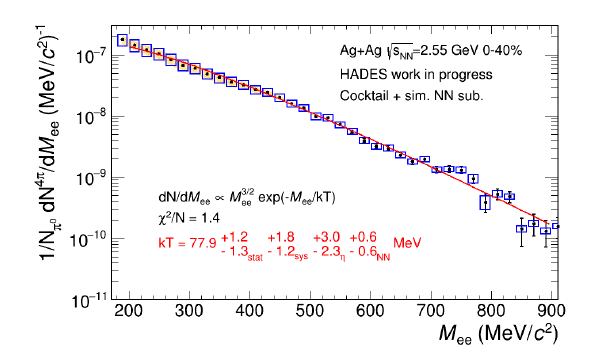
Figure 5. Subtraction of the hadronic cocktail and the initial NN contribution reveals the in-medium dielectron signal. The exponential shape is fitted with a thermal distribution resulting in an integrated medium temperature of T ∼ 78 MeV . The uncertainty in the η multiplicity is indicated by the yellow